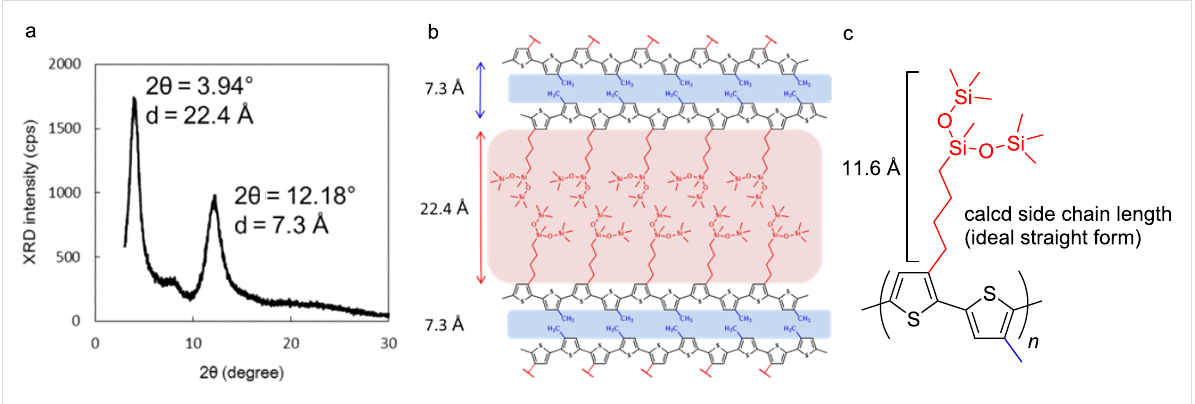
Figure 2: XRD measurement and prediction of the bilayer lamellar structure of polymer 6c . a) XRD analysis. b) Suggested bilayer lamellar structure. c) Side chain length.